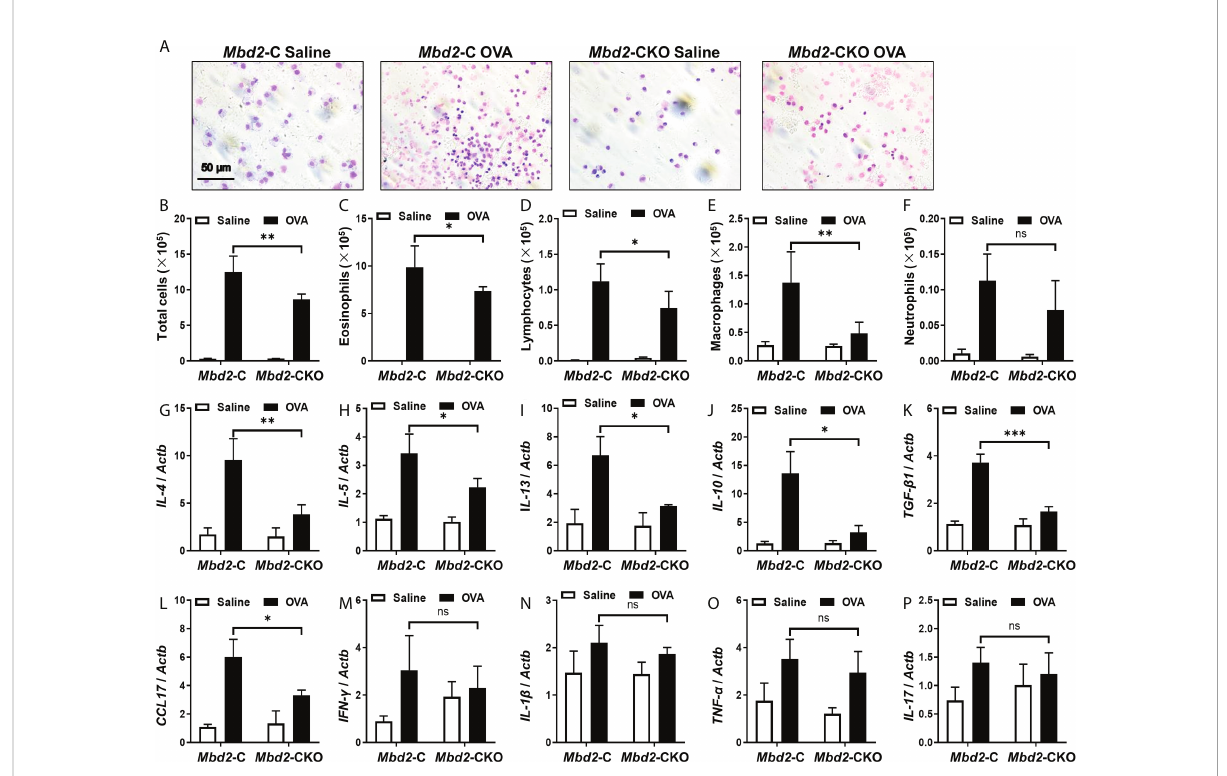
FIGURE 3 Comparison of the number of in fl ammatory cells and cytokines between Mbd2 -CKO and Mbd2 -C mice after 3 days of OVA challenge. (A) : Representative results of Giemsa staining of in fl ammatory cells in BALF samples from OVA-challenged mice. (B-F) : Analysis of the total in fl ammatory cells (B) , eosinophils (C) , lymphocytes (D) , macrophages (E) and neutrophils (F) in BALF samples. (G-P) : RT-PCR analysis of the in fl ammatory mediators IL-4 (G) , IL-5 (H) , IL-13 (I) , IL-10 (J) , TGF- b 1 (K) , CCL17 (L) , IFN- g (M) , IL-1 b (N) and TNF- a (O) and IL-17 (P) in lung samples from OVA-challenged mice. Four to fi ve were included for each study group. ns, not signi fi cant *p < 0.05; **p < 0.01; ***p < 0.001.